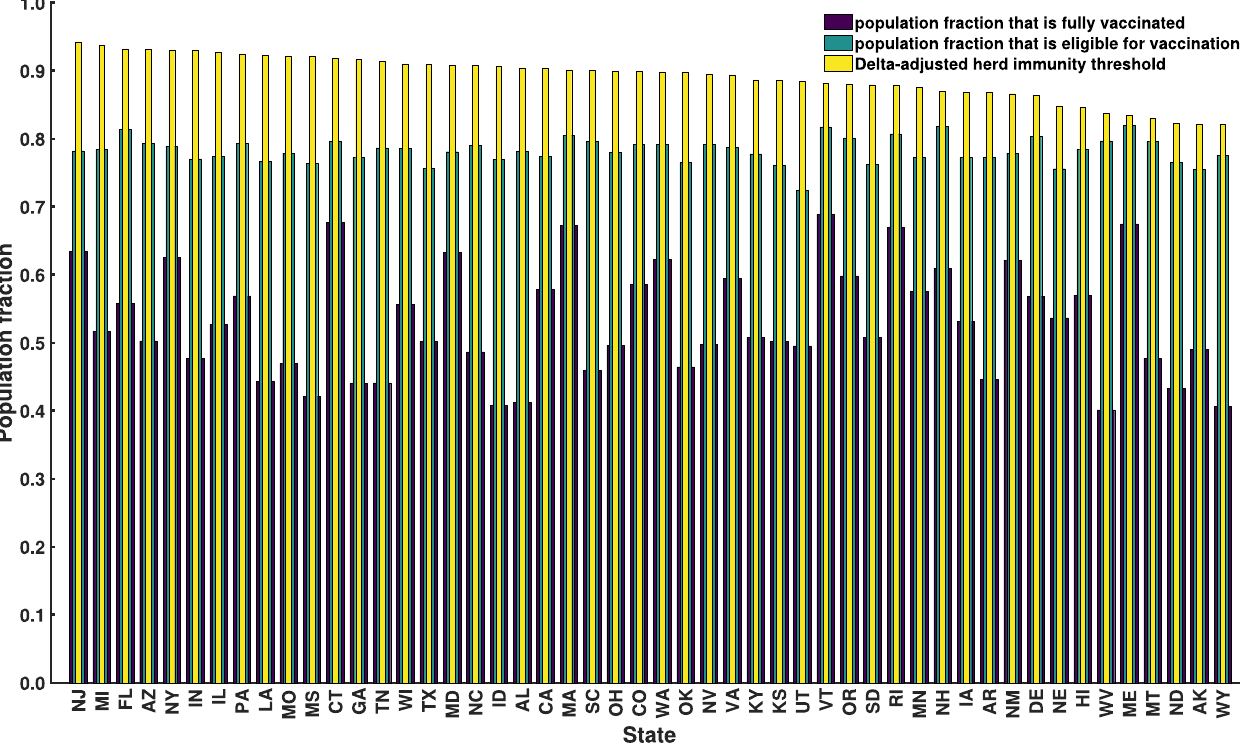
Figure 9. Vaccine eligibility and vaccine coverage in each of the 50 US states on 20 September 2021. Purple bars correspond to vaccine coverage, i.e., the population fraction that is fully vaccinated [24]. Teal bars correspond to vaccine eligibility, i.e., the population fraction that is eligible for vaccination. We estimated the eligible population fraction as the adult fraction of the population [47], i.e., the population fraction 18 years or older. Yellow bars correspond to Delta-adjusted HIT estimates from Supplementary Materials Table S2. States are indicated using two-letter US postal service state ab- breviations